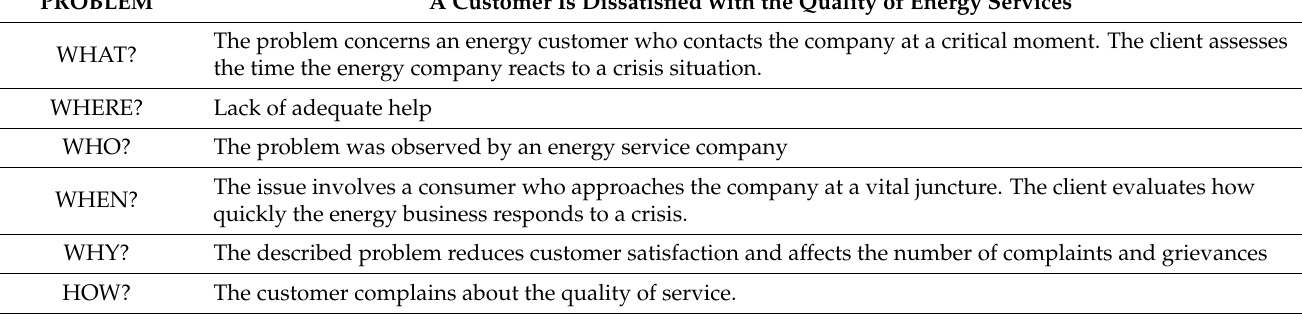
Table 5. The 5W1H method for the problem: The customer is dissatisfied with the quality of energy